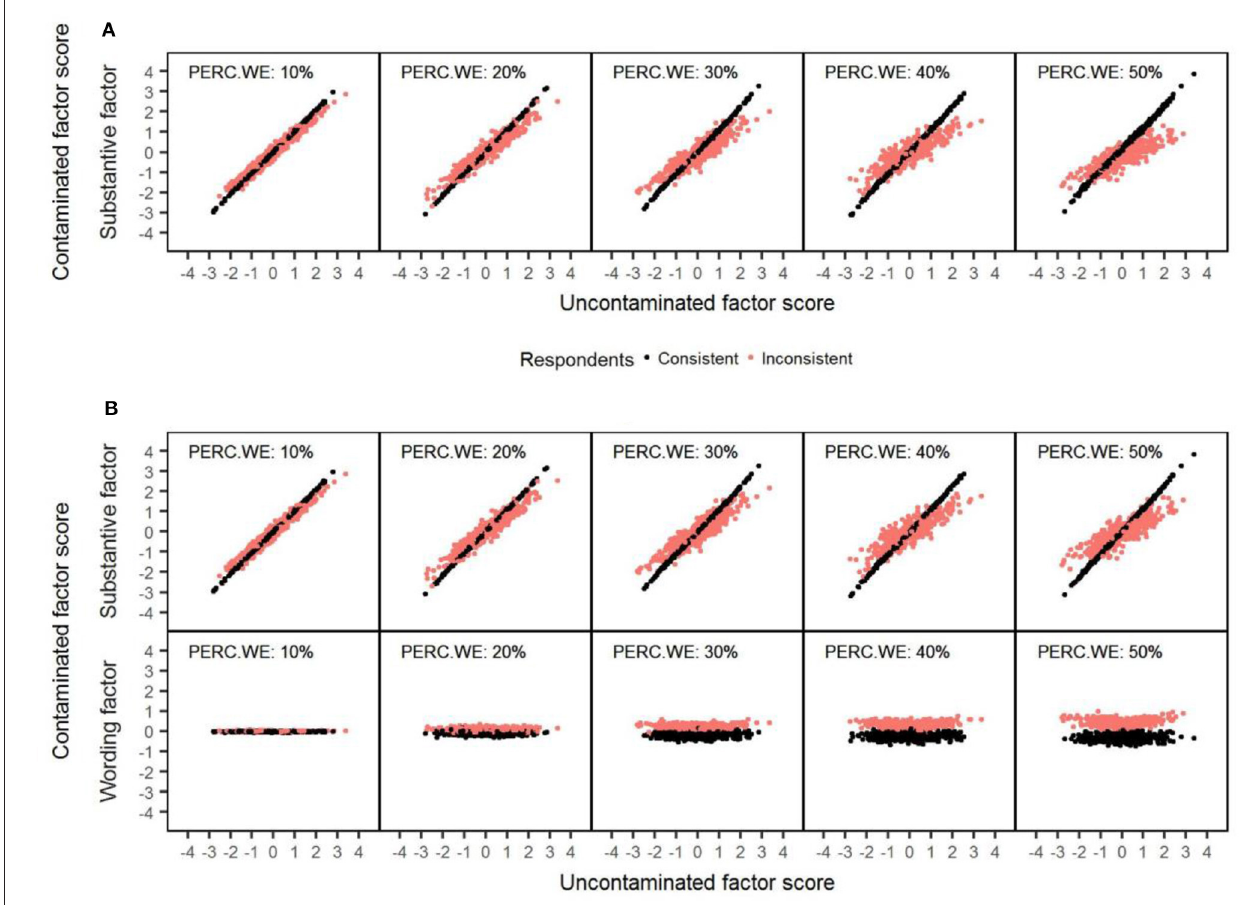
FIGURE 10 | Example of recovery of the substantive factor scores with the 1F and RIIFA models in the presence of acquiescence. The data represented corresponds to simulated unidimensional data sets with 1,000 respondents and 20 variables. 1F, unidimensional model with one substantive factor; RIIFA, random intercept item factor analysis model with one substantive factor and one wording method factor; PERC.WE, amount of wording effect. (A) 1F model. (B) RIIFA model.